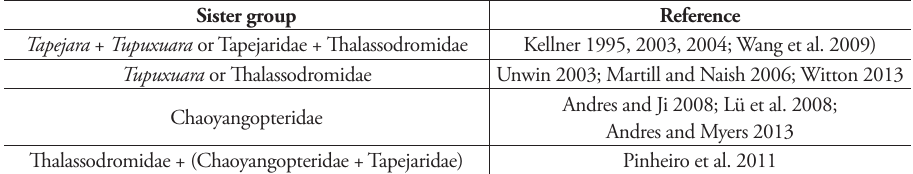
Table 1. Sister group for Azhdarchidae in the analyses which recover the monophyletic